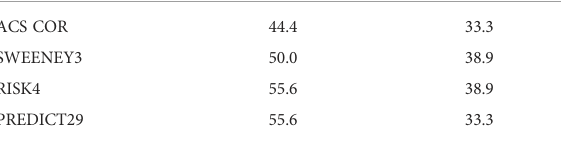
Table depicting the percentage of malnourished individuals with higher ssGSEA scores than the 75 th or 90 th percentile cutoffs of the controls for each TB risk signature.